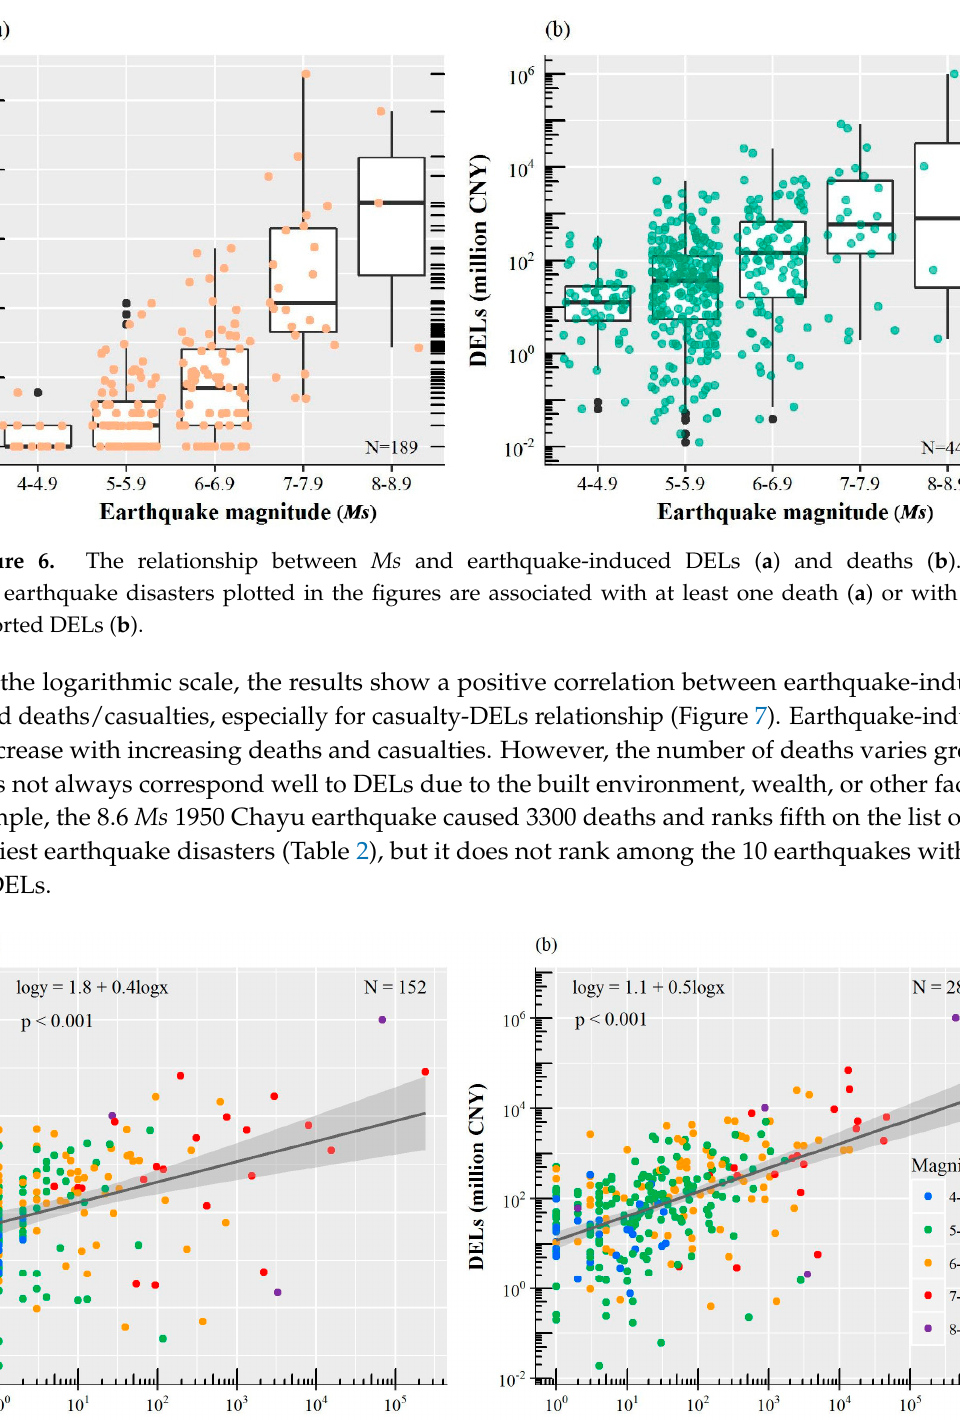
Figure 7. Earthquake-induced DELs versus deaths ( a ) and casualties ( b ) by earthquake magnitude. ( a ) The earthquake disasters plotted in these figures are earthquakes with both at least one death and reported DELs. ( b ) Same as ( a ), but for casualties. Nonparametric smooth curves with 95% confidence interval are shown in gray.